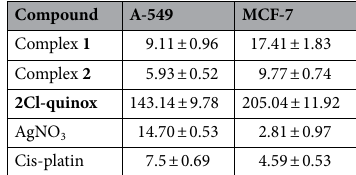
Table 3. IC 50 values (in µg/mL) for the Ag(I) complexes, 2Cl-quinox , AgNO 3 and cis -platin against selected cancer cell